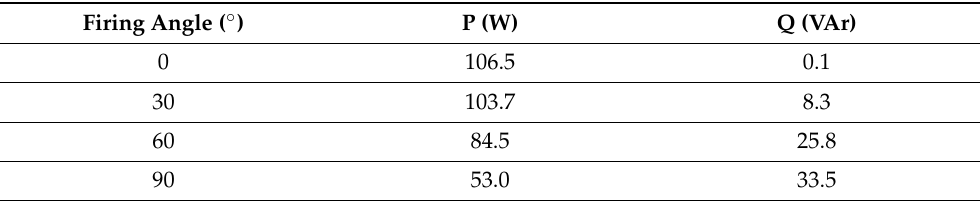
Table 13. Power reference values for the resistive